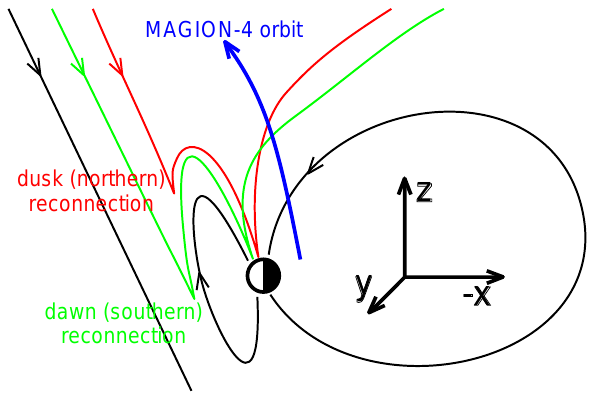
Fig. 8. A sketch of a magnetospheric topology during the investi- gated event in the time interval when IMF B Z is negative.